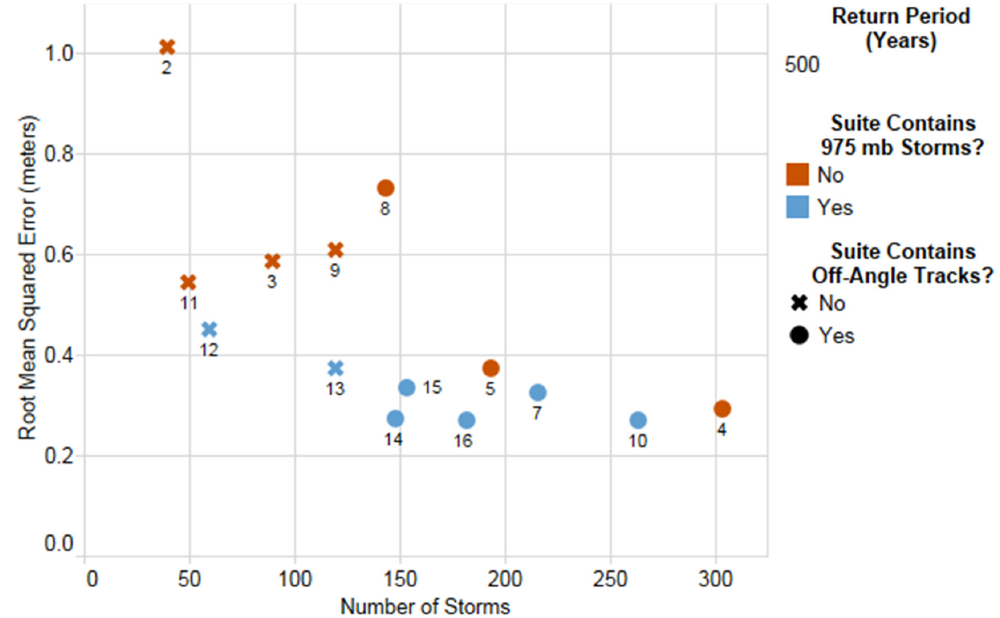
Figure 2. Average coastwide bias and variation by number of storms (screening analysis), 500-year flood depths.